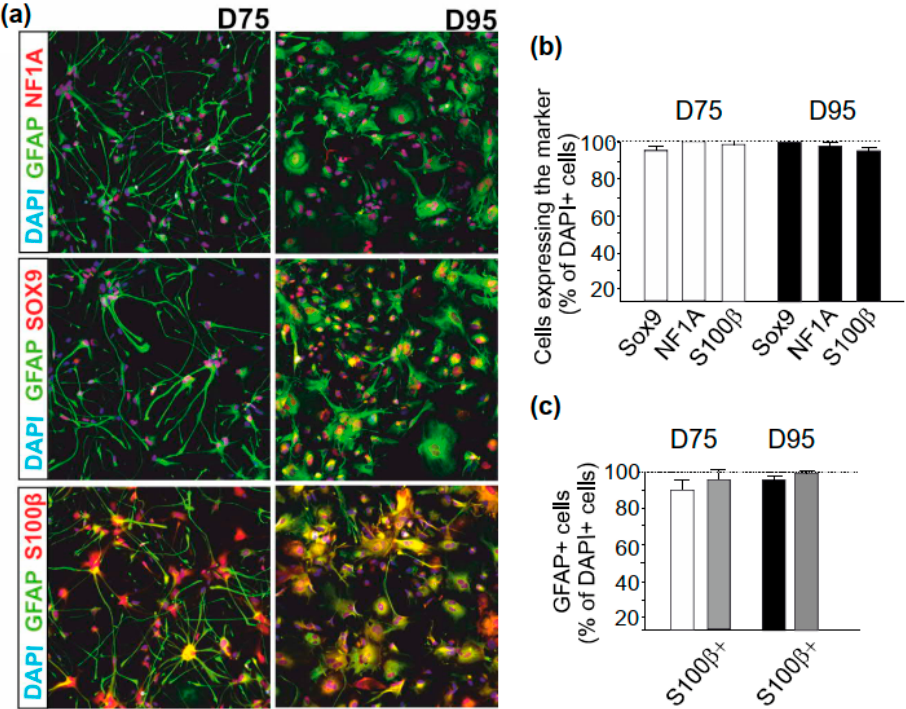
Figure 3. Immunostaining for astrocyte markers. ( a ) Representative images of astrocytes showing immunocytochemistry for astrocyte markers (overlay and separately for NF1A, SOX9, S100b, glial fibrillary acidic protein (GFAP), and DAPI nuclear staining) at D75 and D95. ( b ) Bar graphs showing percentage of Sox9, NF1A, and S100b immunopositive cells at D75 and D95. n = 3 cell lines, analysis of triplicate samples of each cell line. ( c ) Percentage of GFAP immunopositive cells at D75 and D95. n = 3 cell lines. Triplicate samples of each cell lines were analyzed. Data are expressed as mean ± SEM.